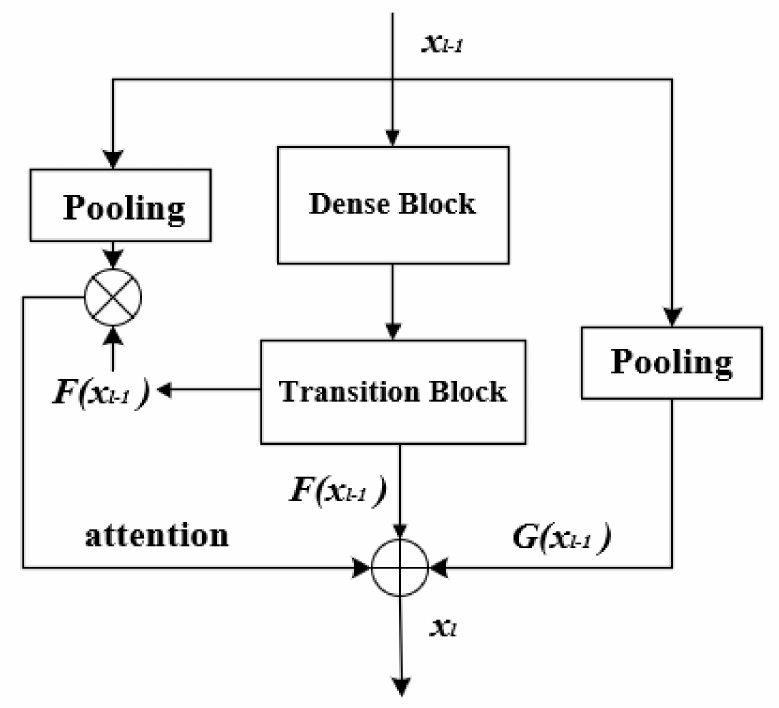
Figure 3. Architecture of ARDT Blocks. The “ ⊗ “represents matrix